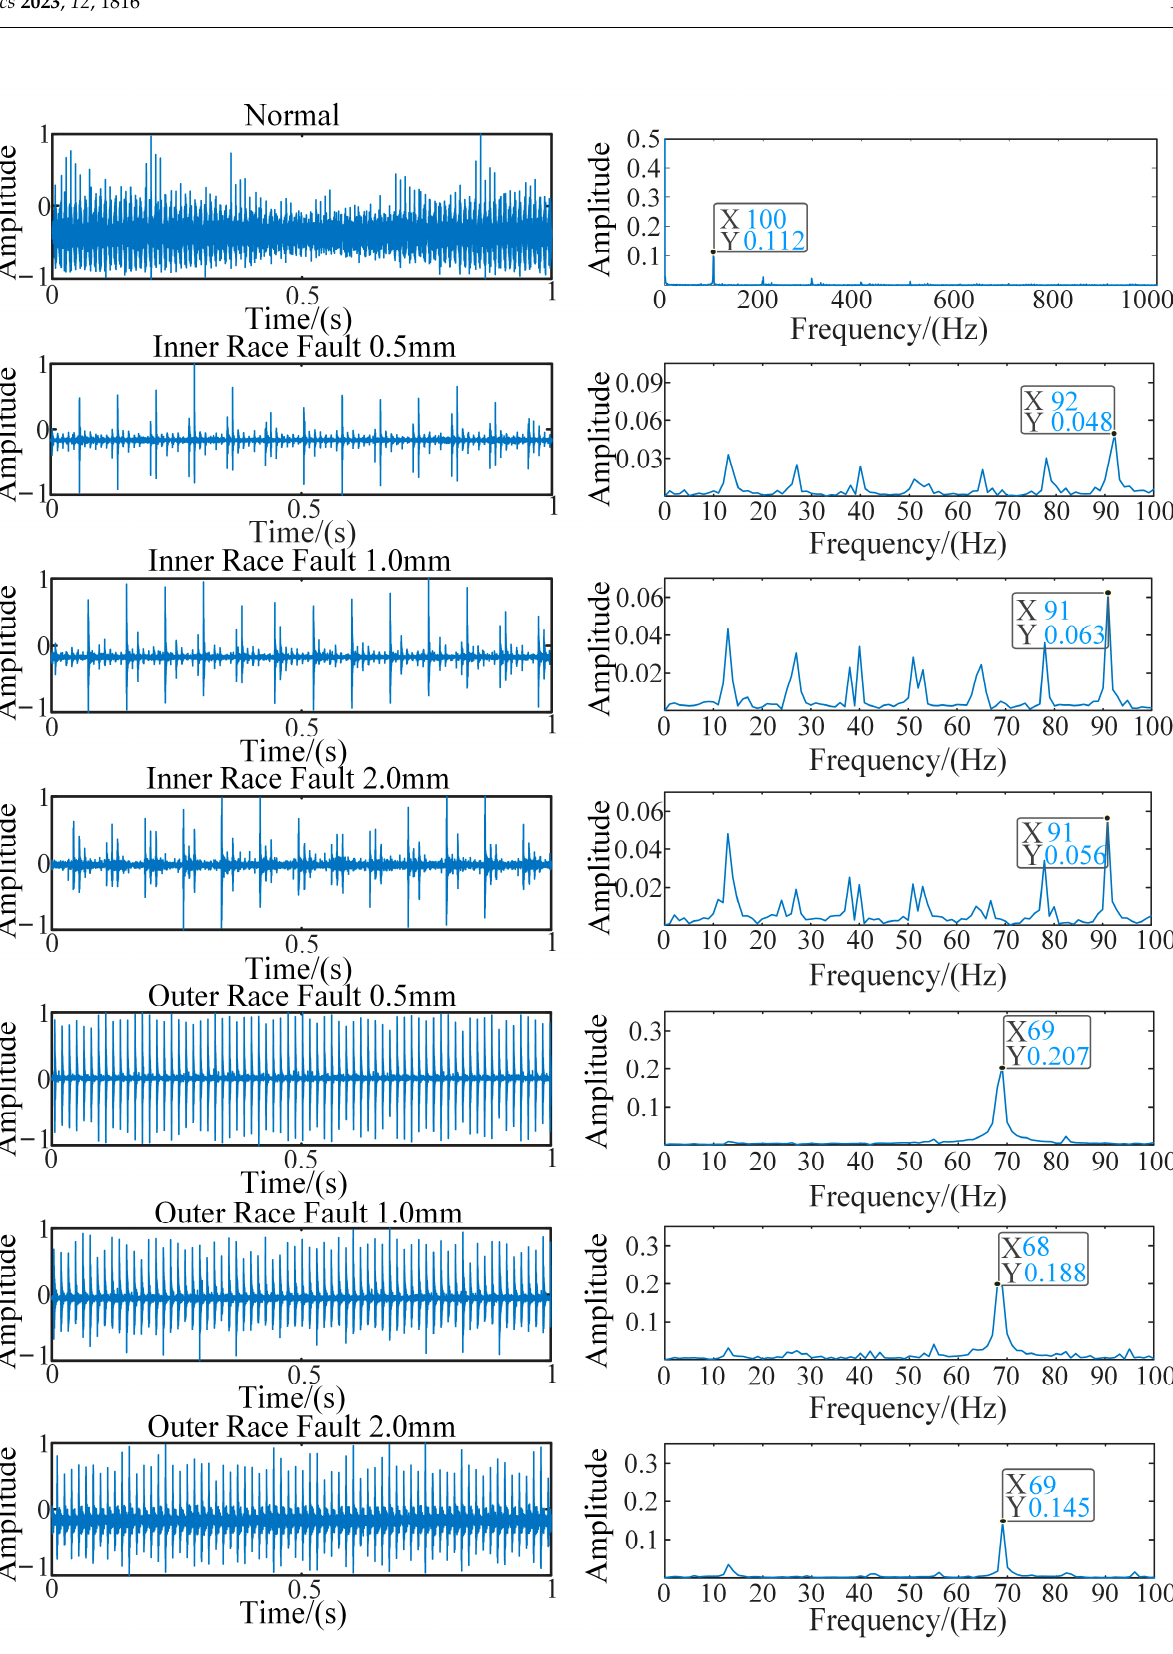
Figure 10. Time domain and envelope spectrum images of bearings in seven statuses.